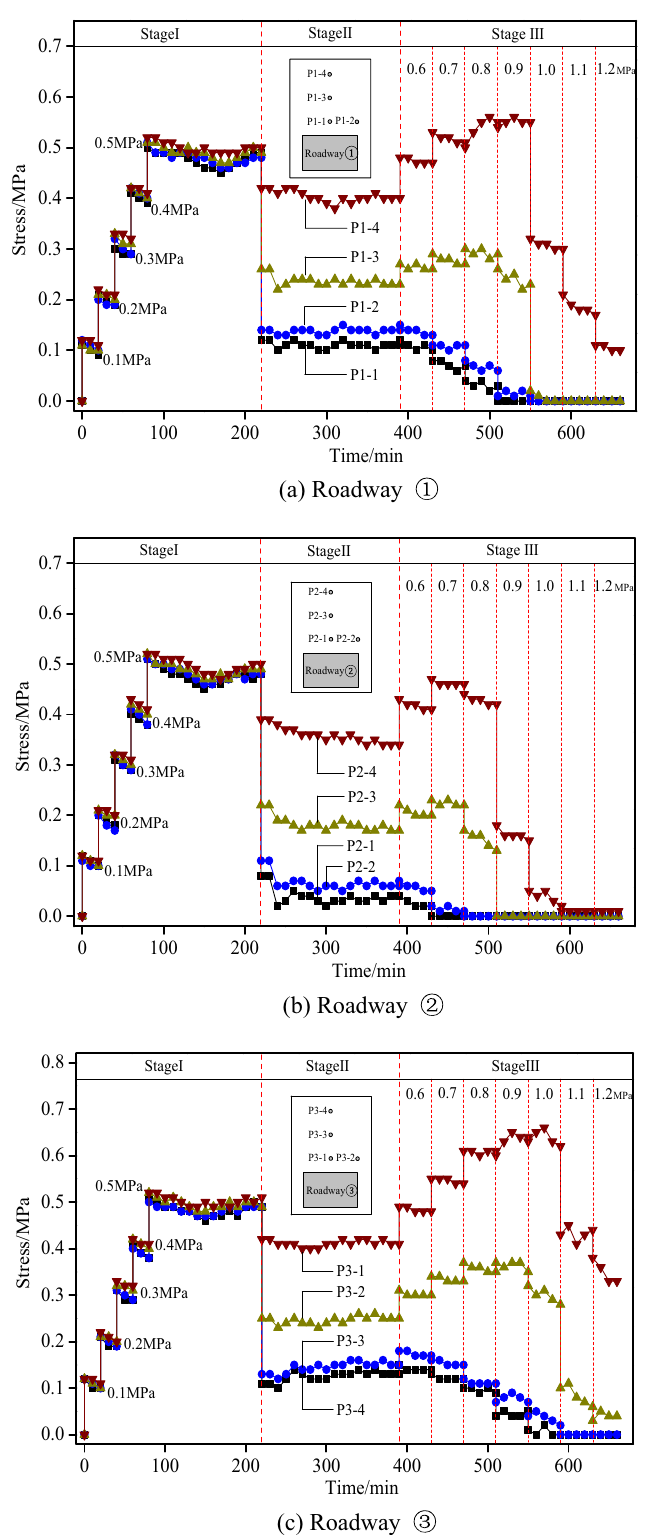
Figure 14. Stress evolution curves of roadway surrounding